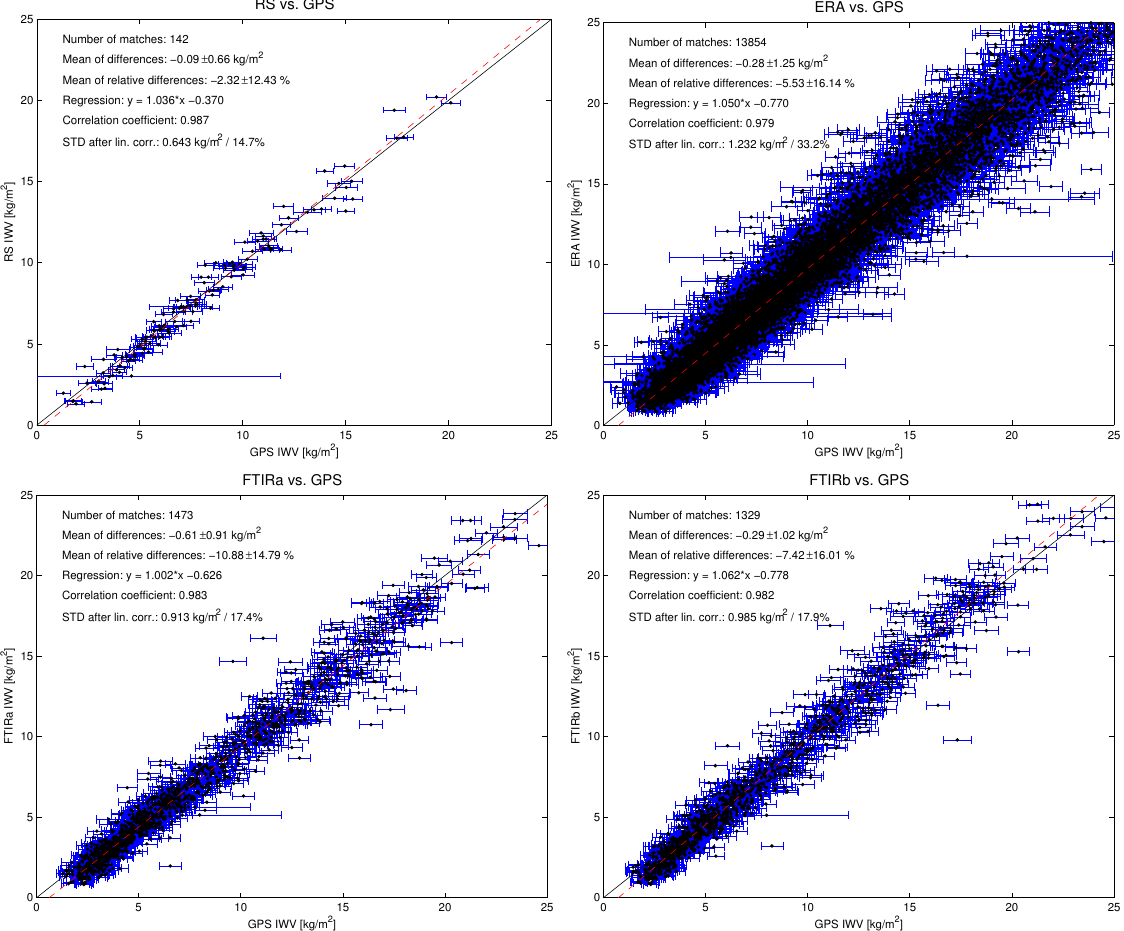
Fig. 6. Scatterplots of other datasets versus GPS: Radiosonde (top left), ERA-Interim (top right), FTIRa (bottom left), and FTIRb (bottom